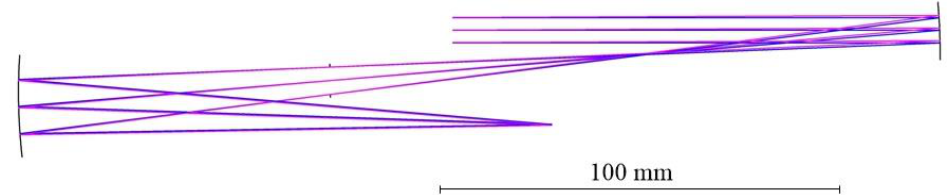
Figure 5. The layout of the initial freeform anamorphic system.